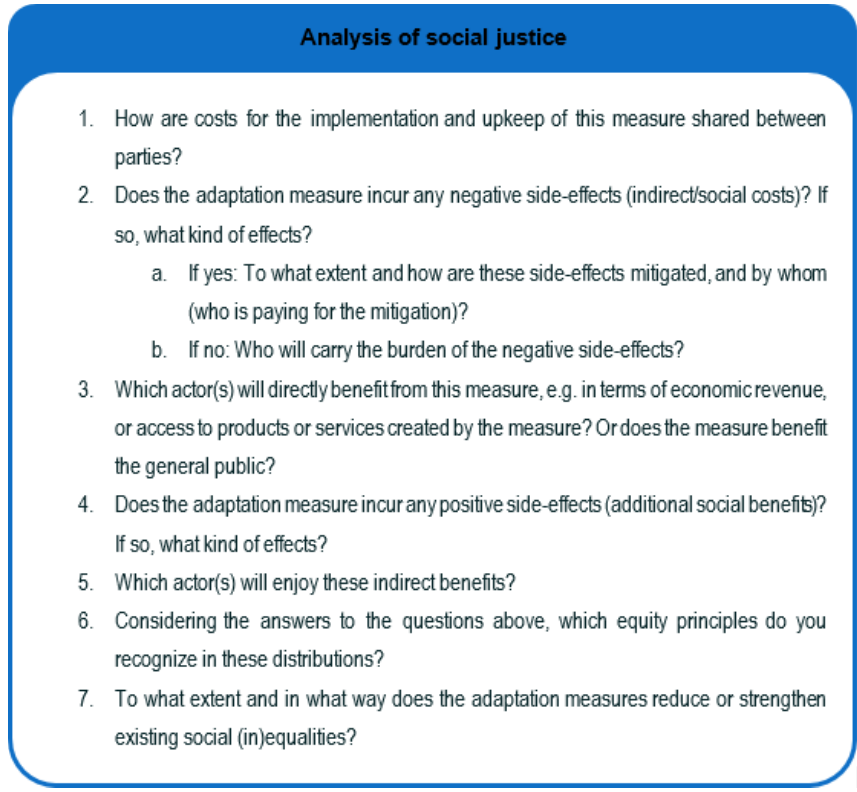
Figure 2. Questionnaire for social justice